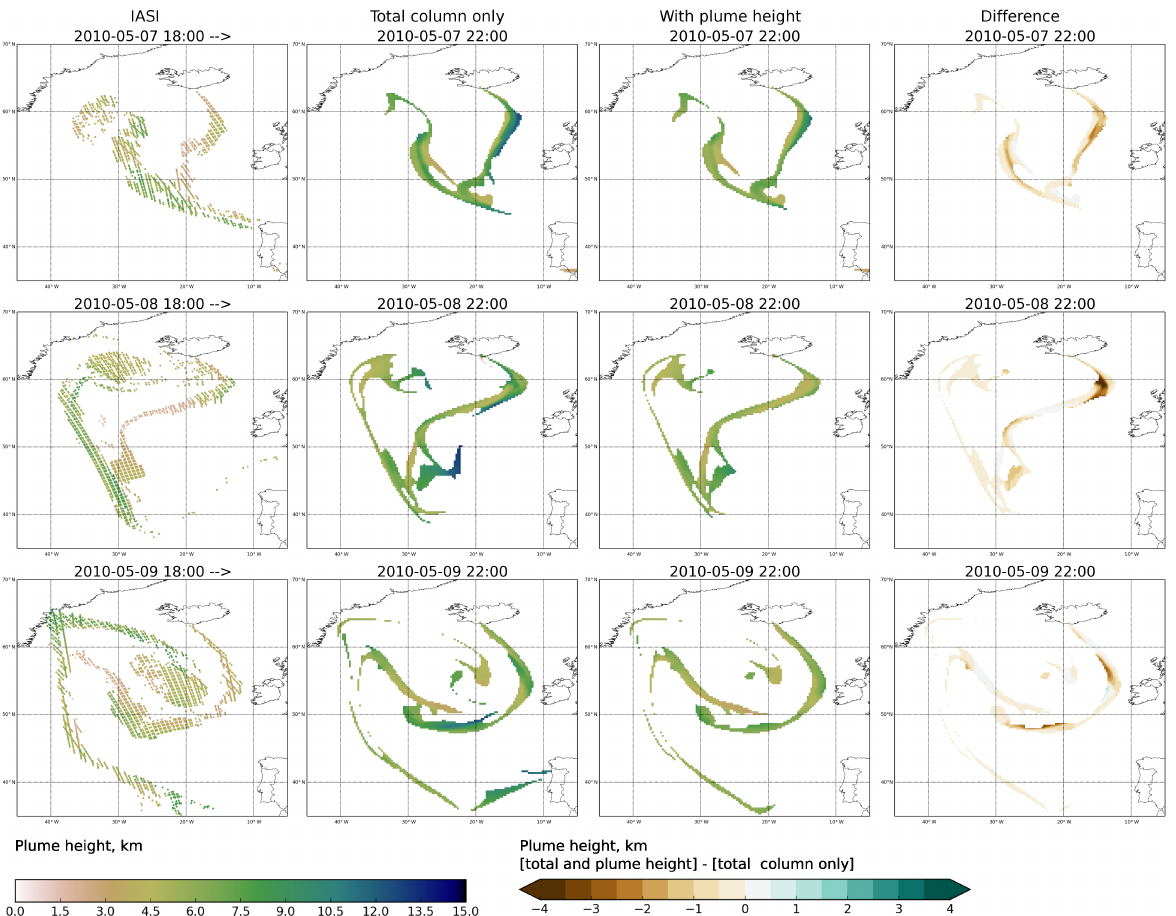
Figure 10. Retrieved SO 2 plume height (km, left column) and the simulated plume height (as centre of mass) without and with assimilation of plume height retrievals for 7–9 (top to bottom row) May 2010. The difference (with plume height – without plume height) of the simulations is shown in the right-most